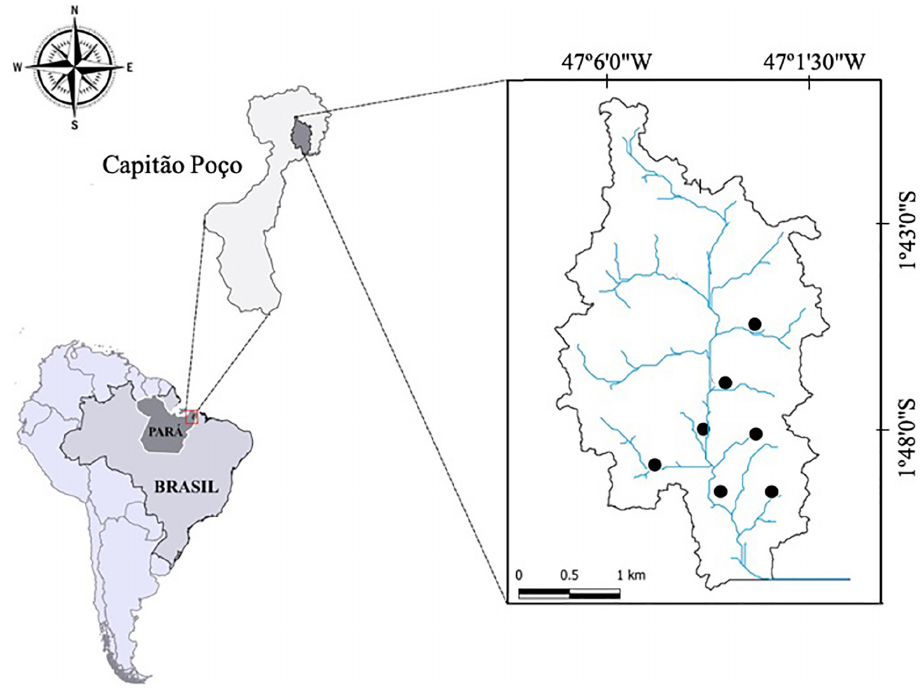
FIGURE 1 | Study streams (black dots) in a catchment of the Guamá River in the municipality of Capitão Poço, Pará State,